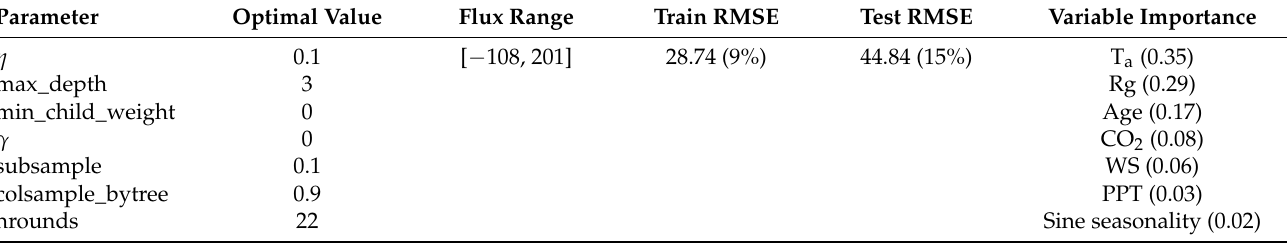
Table 2. Summary of the XGBoost models for NEP (g C m − 2 month − 1